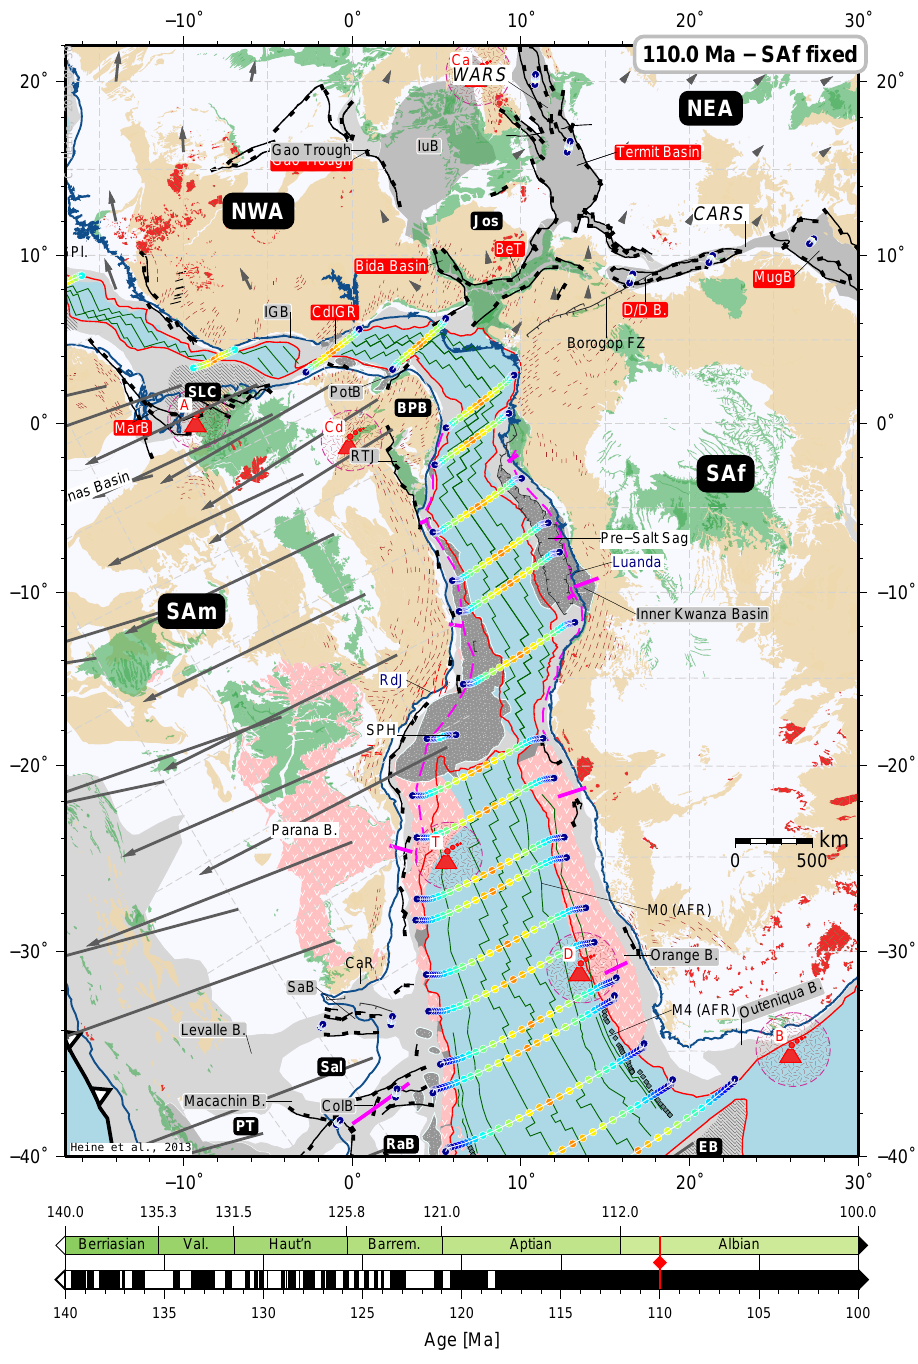
Fig. 20. Plate tectonic reconstruction at 110Ma, with Africa fixed in present-day coordinates. For map legend see Fig. 22, abbreviations as in Fig. 13. Full continental separation is achieved at this time, with narrow oceanic gateways now opening between the Cˆote d’Ivoire/Ghana Ridge and the Piaui-C´eara margin in the proto-equatorial Atlantic and between the Ewing Bank and Aghulas Arch in the southernmost South Atlantic. Deformation related to the break-up between Africa and South America in the African intracontinental rifts ceases in post-Aptian times. Towards the top Aptian, break-up between South America and Africa has largely been finalised. The only remaining connections are between major offset transfer faults in the equatorial Atlantic rift and between the outermost Santos Basin and the Benguela margin where a successively deepening oceanic gateway between the northern and southern proto-South Atlantic is proposed. Seafloor spreading is predicted for the conjugate passive-margin segments such as the Deep Ghanaian Basin (DGB). The stage pole rotation between SAm and NWA predicts compression along the CdIGR in accordance with observed uplift during this time (e.g. Pletsch et al., 2001; Clift et al., 1997). Abbreviations: CdIGR – Cˆote d’Ivoire/Ghana Ridge; EB – Maurice Ewing Bank. Solid Earth, 4, 215–253,